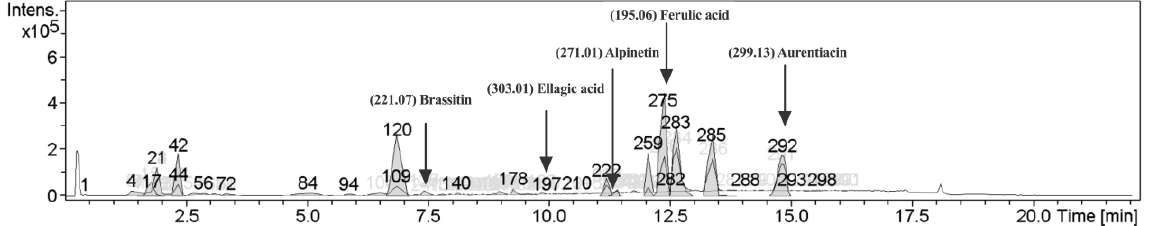
Figure 1. Chromatographic diagram of bioactive ingredients in ethanolic seed extract (CNSE) by liquid chromatography-mass spectrometry (LC-MS) analysis.